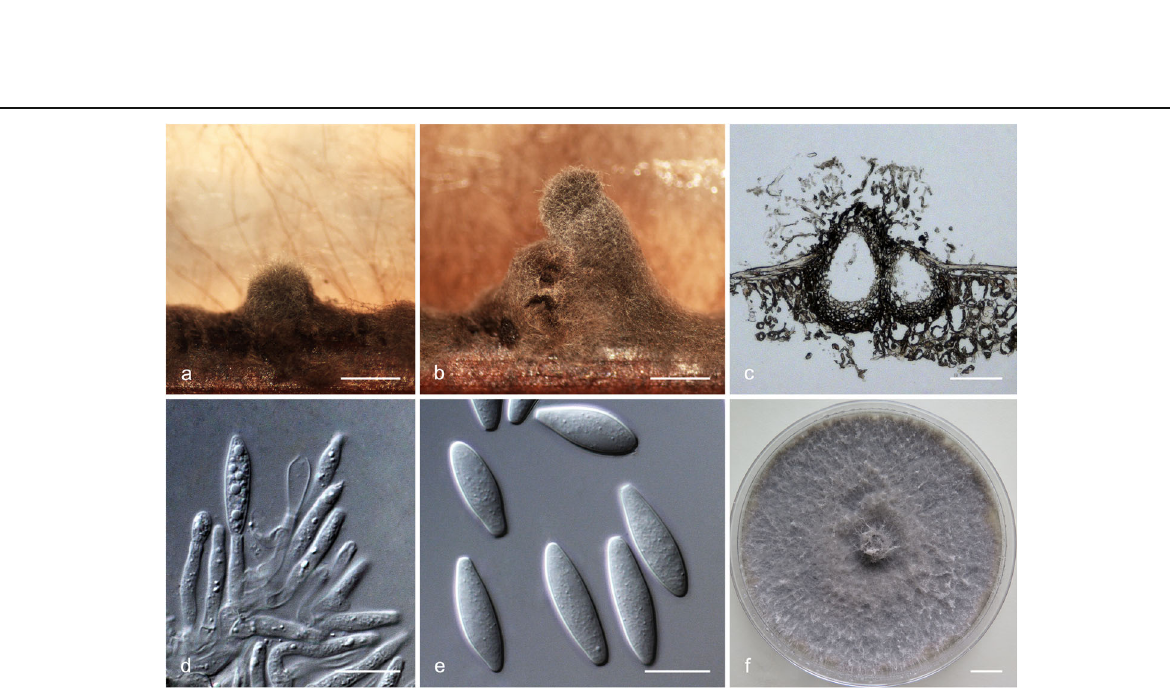
Fig. 6 Neofusicoccum dianense. a , b . Conidiomata formed on pine needle culture; c . Longitudinal section through conidiomata; d . Conidiogenous cells and developing conidia; e . Conidia; f . Living culture after 10 d on 2% MEA (front). Scale bars: a, b = 500 μ m; c = 100 μ m; d, e = 10 μ m; f = 1 cm